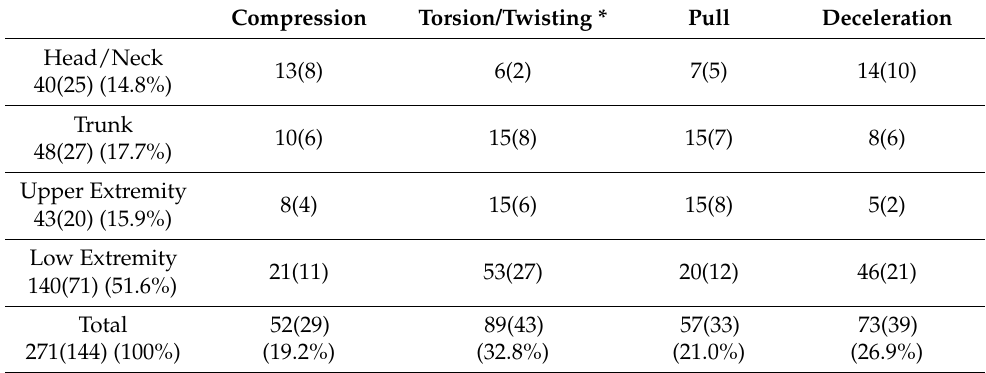
Table 4. The distribution of mechanics of injury.